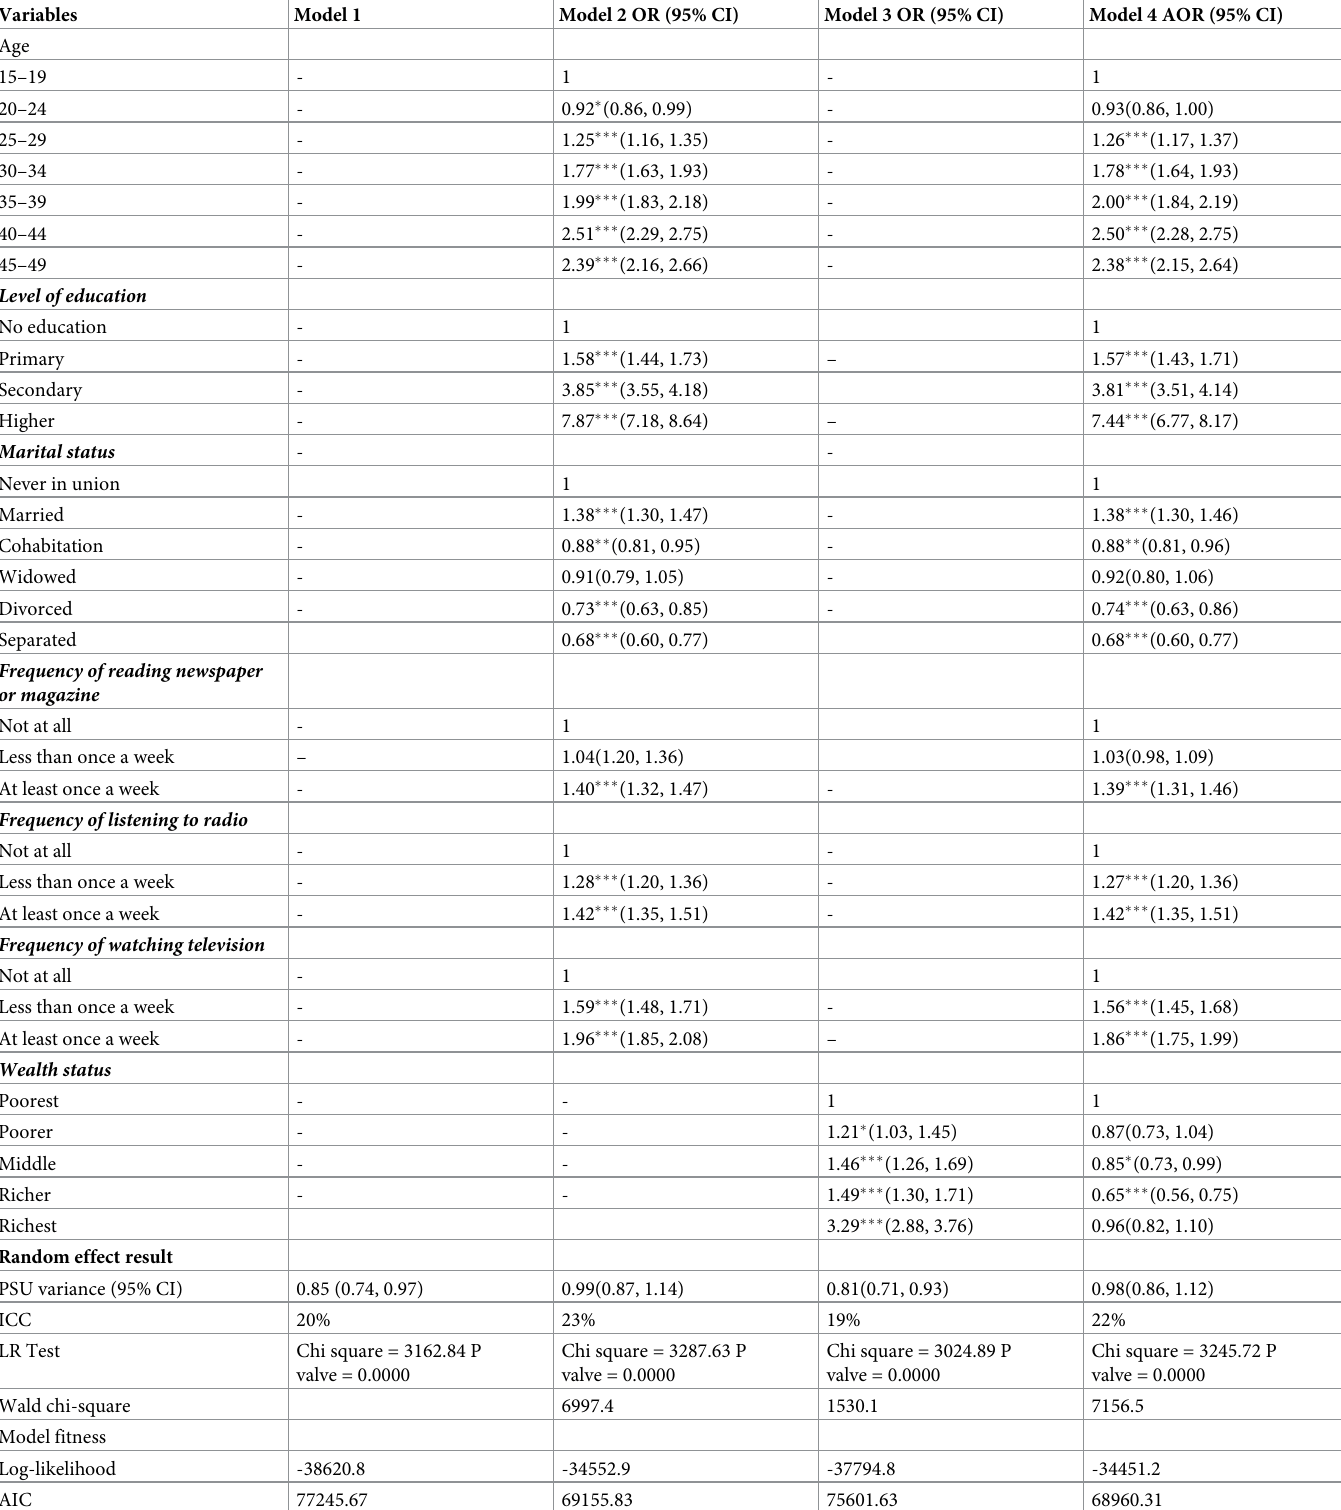
Table 3. Multilevel binary logistic regression results on the factors associated with health insurance coverage among females in